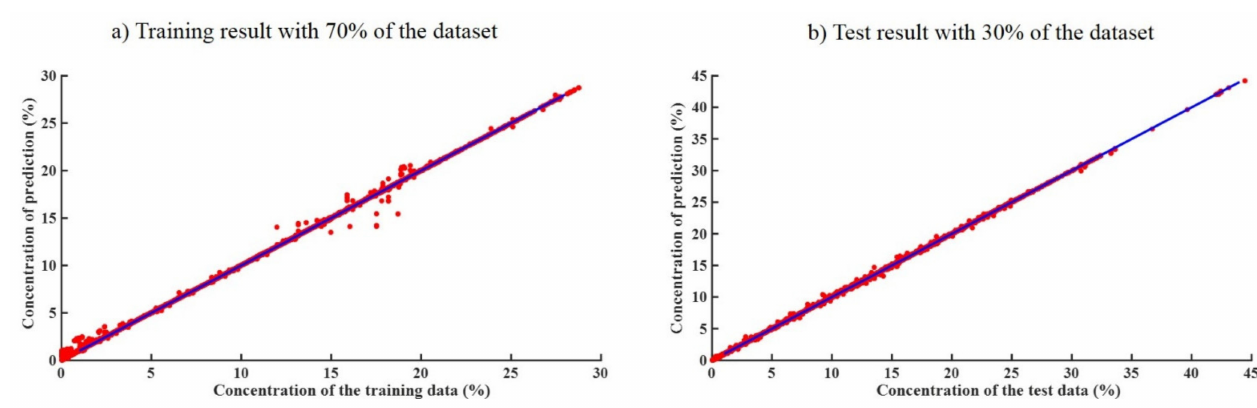
Figure 9. The learning results of 7:3 proportion.